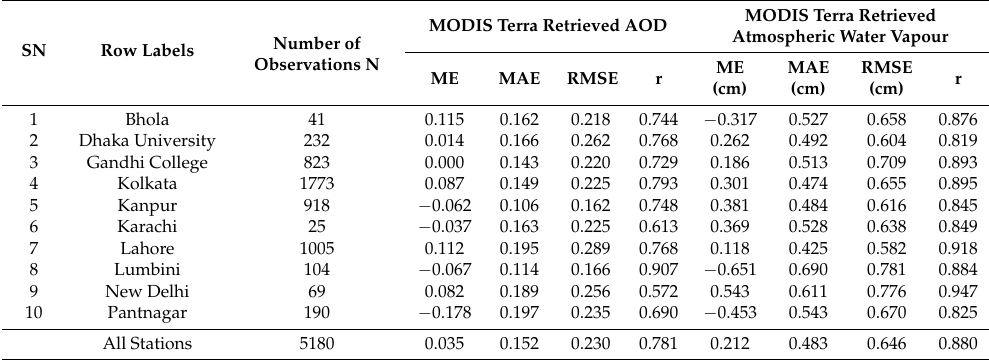
Table 7. Evaluation of MODIS Terra derived AOD and atmospheric water vapour against AERONET measured AOD and atmospheric water vapour for the IGP stations. MODIS Terra Retrieved MODIS Terra Retrieved AOD Atmospheric Water Vapour SN Row Labels Number of Observations N ME MAE